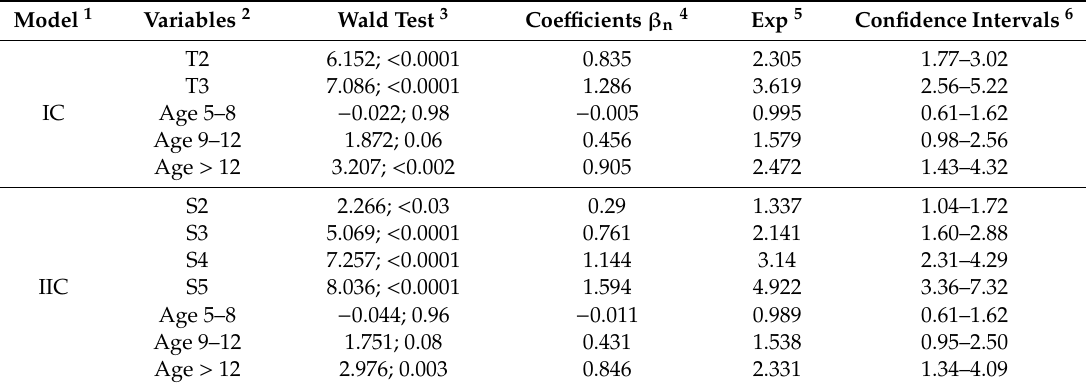
Table 3. Models with categorical